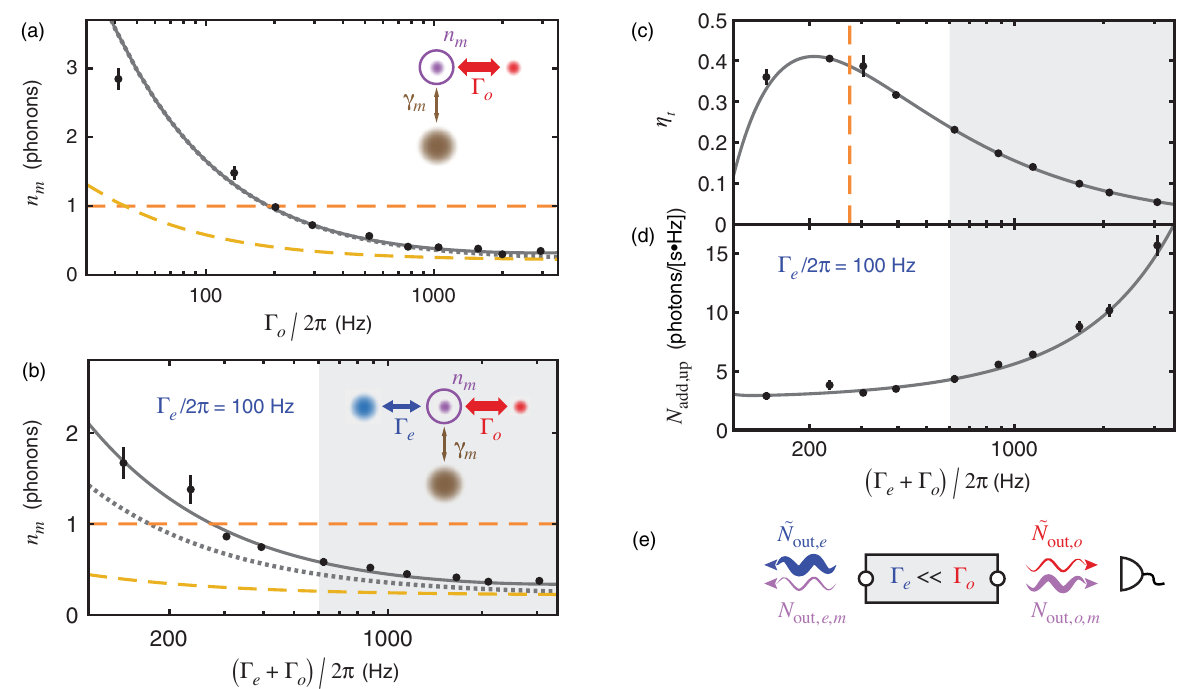
FIG. 2. Ground-state cooling of electro-optomechanical transducer. (a) Membrane mode occupancy n damping rate Γ with electromechanical damping Γ o behavior in the absence of technical noise. Orange dashed line indicates n (increase at low Γ due to backaction from auxiliary optical cavity lock beam). Inset illustrates optomechanical sideband cooling, where o external blurred disks represent baths (with size indicating occupancy) to which the membrane mode (purple circle) is coupled by the corresponding damping rates (arrows, with width indicating magnitude). The membrane mode occupancy (purple blurred disk) is determined by the weighted average of bath occupancies. (b) n Γ = 2 π ¼ 100 Hz, with curves color coded as in (a). Inset illustrates relative bath occupancies and damping rates for electro- e optomechanical sideband cooling in the gray shaded region where Γ in (b), with fit. Orange dashed line marks the damping at which n theory curve. (e) Schematic representation of transducer output noise in the Γ the transducer, and wavy arrows represent contributions to the microwave and optical output noise around mechanical resonance, from membrane mode occupancy (purple) and technical noise (red and blue), with thickness indicating noise density. Photodetector indicates optical readout. All error bars represent one standard